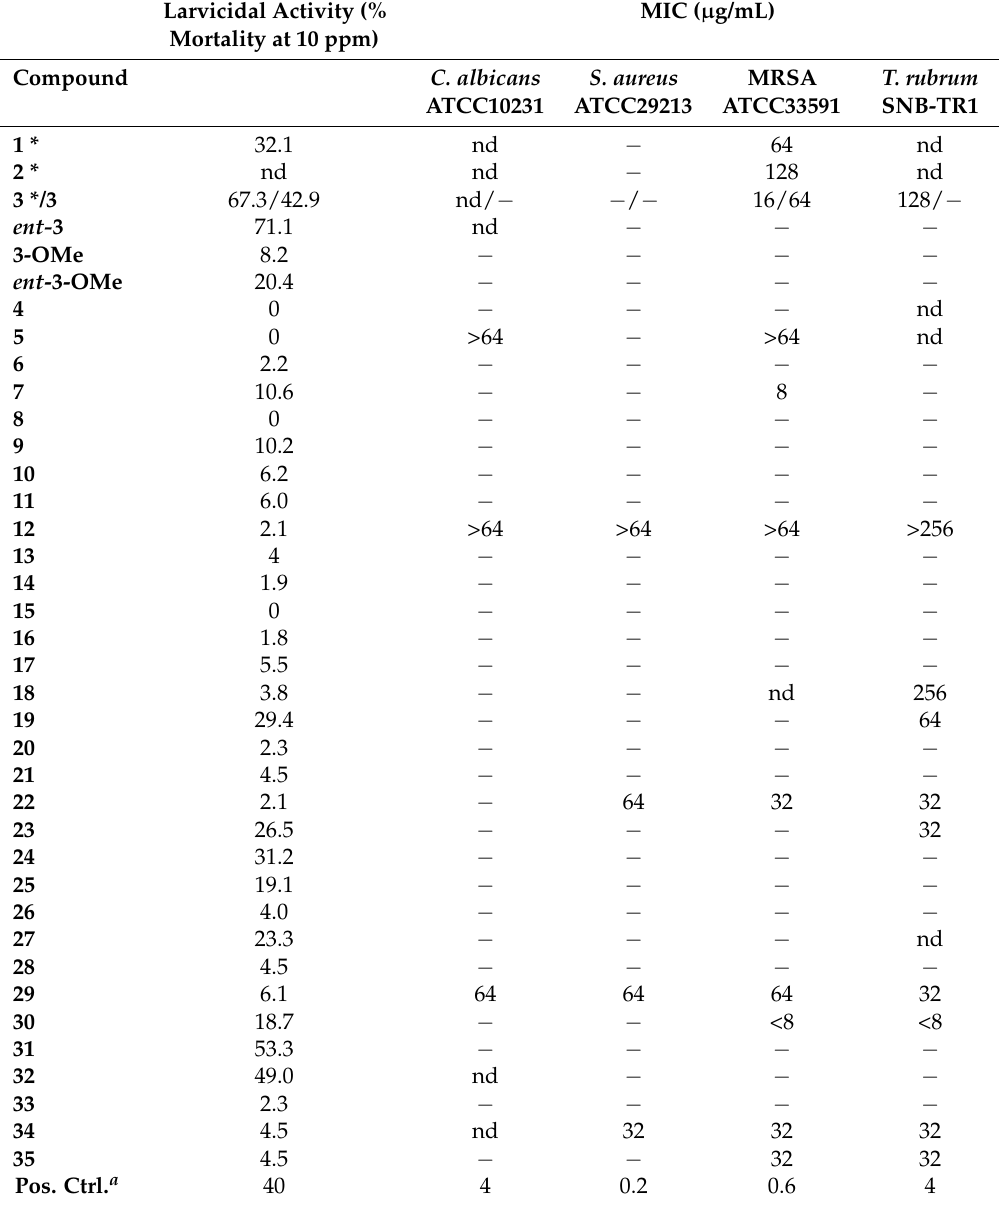
Table 2. Antimicrobial and insecticide activities of compounds 1 – 3 and synthetic analogues 4 – 39. Larvicidal Activity (% Mortality at 10